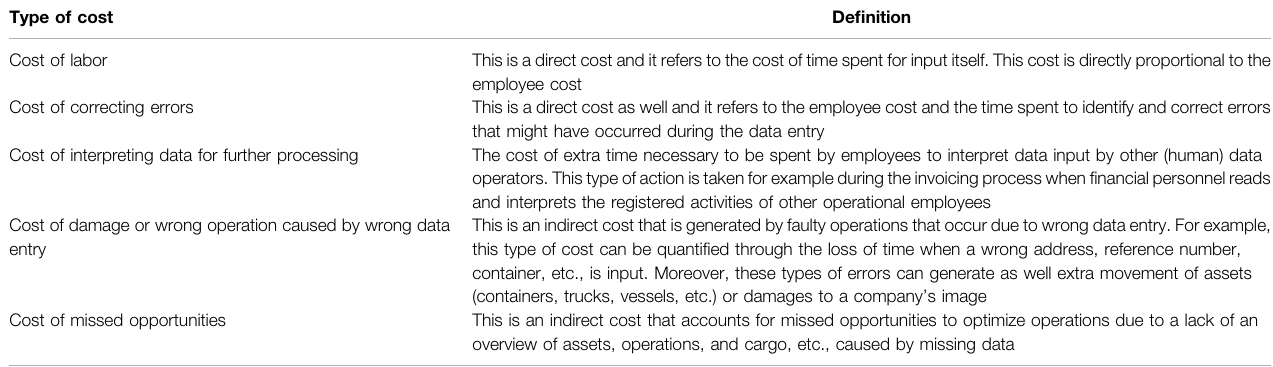
TABLE 3 | Overview of cost types generated by manual data entry. Source: own compilation of literature review fi ndings. Type of